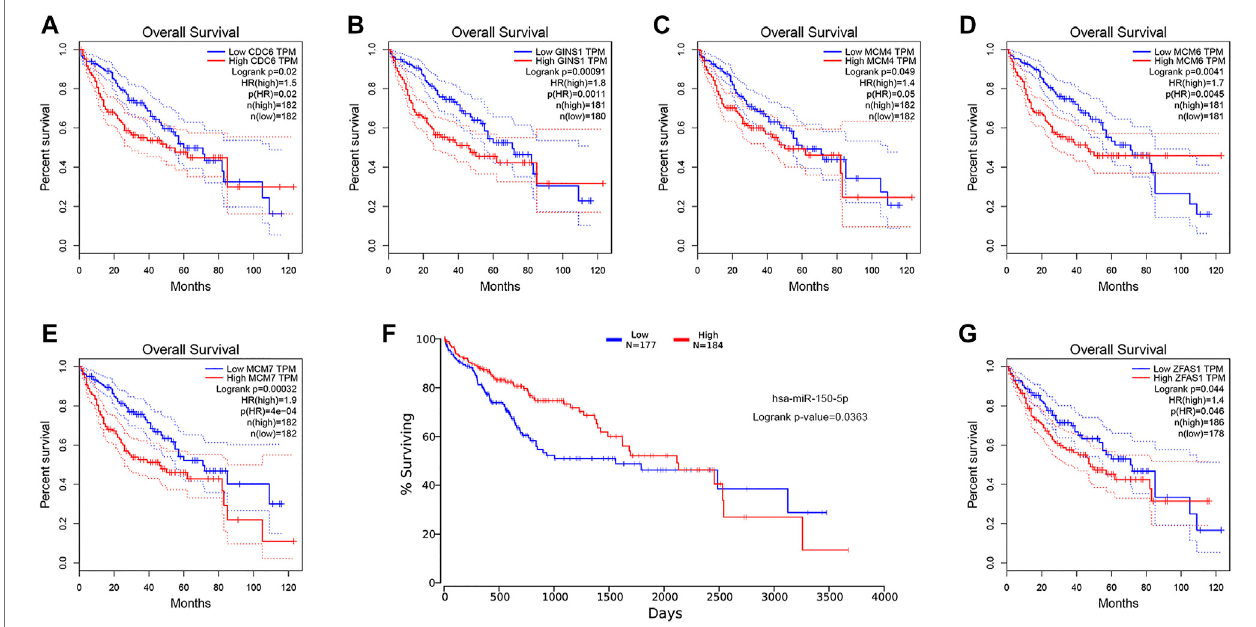
FIGURE 9 | KM survival analysis of the mRNA (A − E) , miRNA hsa-miR-150-5p (F) , and lncRNA ZFAS1 (G) . KM, Kaplan-Meier; mRNA, messenger RNA; miRNA, microRNA; lncRNA, long non-coding RNA; TPM, transcripts per million; HR, hazard ratio.